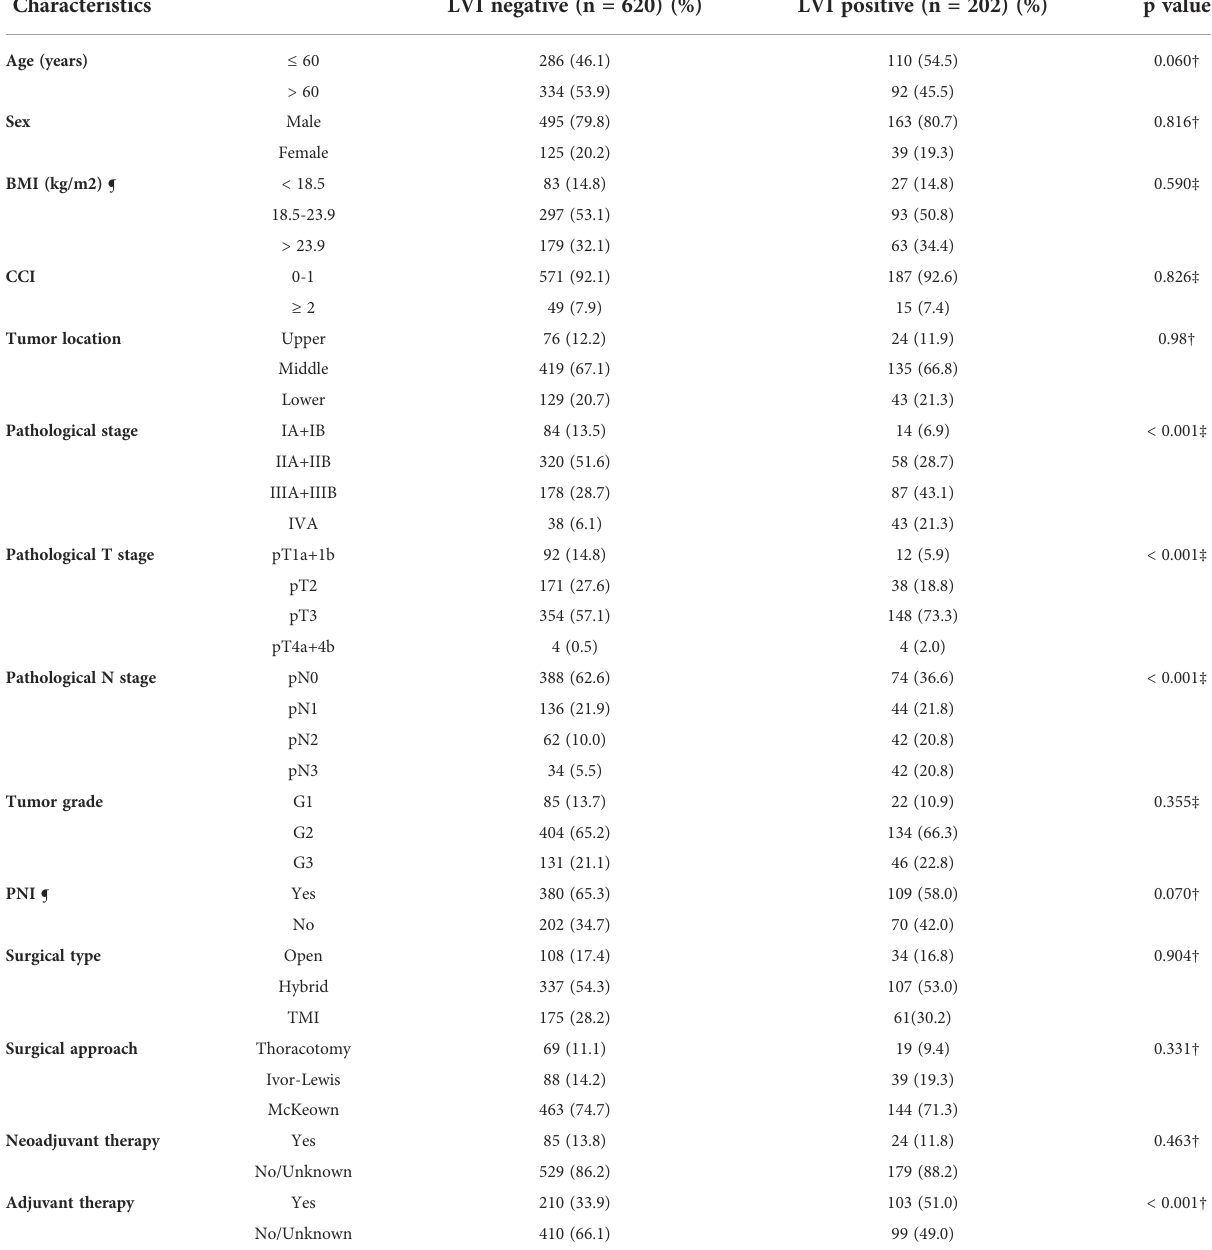
TABLE 1 Association of lymphovascular invasion with clinicopathologic characteristics of patients with resected esophageal squamous cell carcinoma.